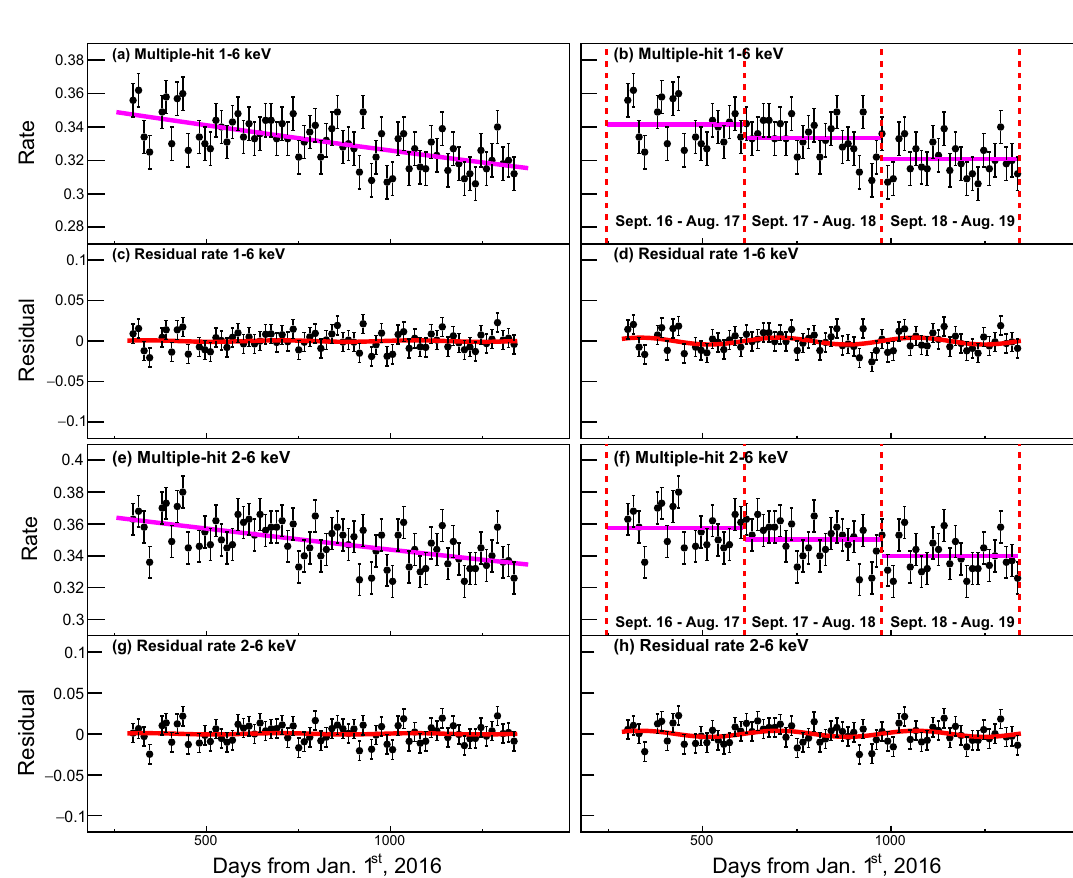
Figure 5. Multiple-hit event rates in the unit of counts/keV/kg/day as a function of time.The top four panels present time-dependent events rates and the residual rates in the multiple-hit 1–6 keV regions with 15-day bin. Here, the event rates are averaged for the five crystals with weights from uncertainties in each 15 days bin size. Purple solid lines present background modeling with the single exponential ( a ) and with the yearly averaged DAMA-like method ( b ). Residual spectra for the single exponential model ( c ) and the DAMA-like model ( d ) are fitted with the sinusoidal function (red solid lines). The bottom four panels show the results for the 2-6 keV region using the same methods. In the multiple-hit events, no strong modulations from both methods are observed.